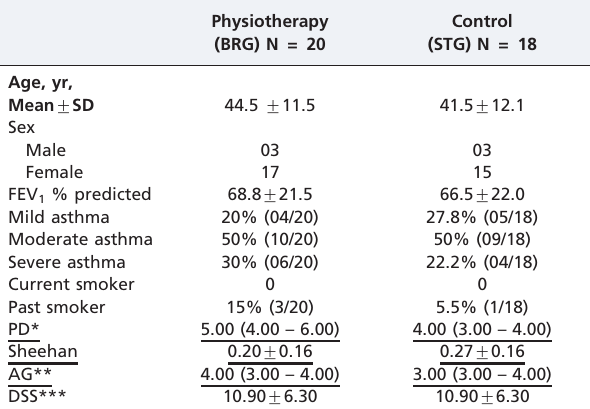
Table 1 - Preliminary patient demographic and spirometry data for both the Breathing Retraining Group (BRG) and the Subtle Touches group (STG). Eighty percent of the BRG patients and 72.2% of the STG patients had moderate/severe asthma. The BRG patients had a higher frequency of previous smoking. Both groups had high scores for panic disorder and agoraphobia, as indicated by the appropriate scales. The BRG and the STG had the same Daily Symptom Diary median